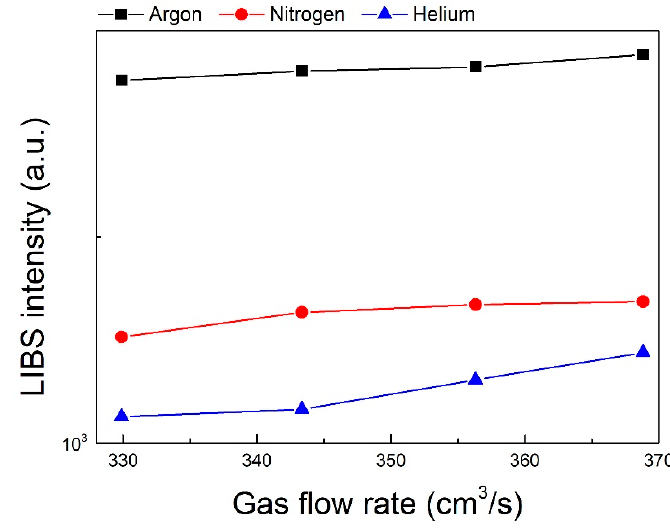
Figure 14. LIBS intensity by flow rate for Ar, N 2 , and He gases.